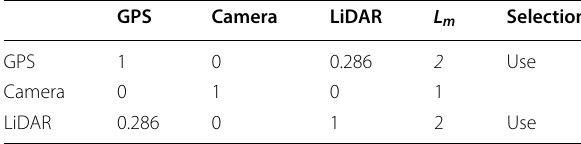
Table 3 Correlation table at 254 s in Fig.